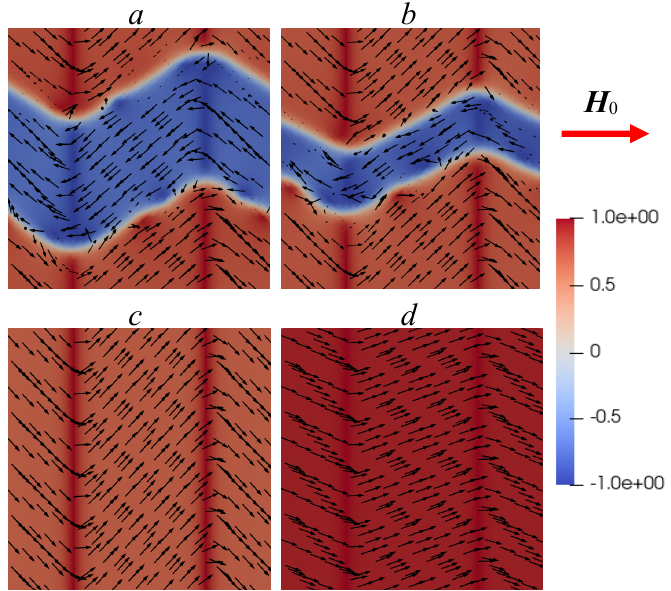
Figure 7. Evolution of the magnetization vector upon application of an external magnetic field along the x axis: ( a )— ˜ H 0 = 0, ( b )— ˜ H 0 = 0.11, ( c )— ˜ H 0 = 0.13, ( d )— ˜ H 0 = 1.5.